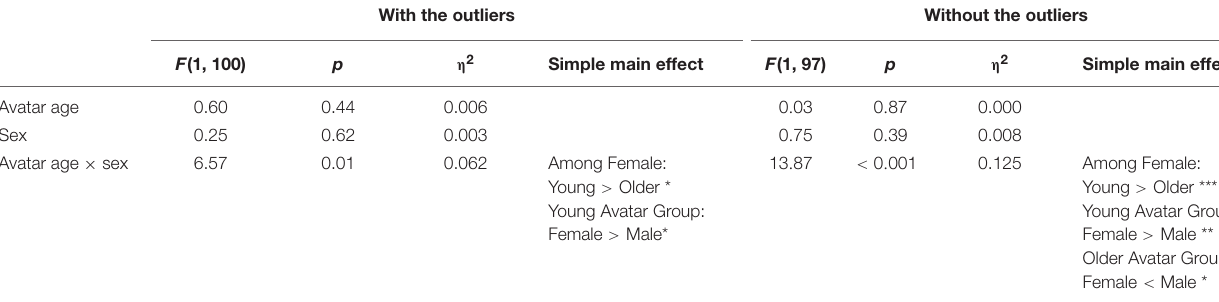
TABLE 2 | Statistics of the 2 × 2 ANOVAs for the vector magnitude of physical activity with and without outliers. With the outliers Without the outliers